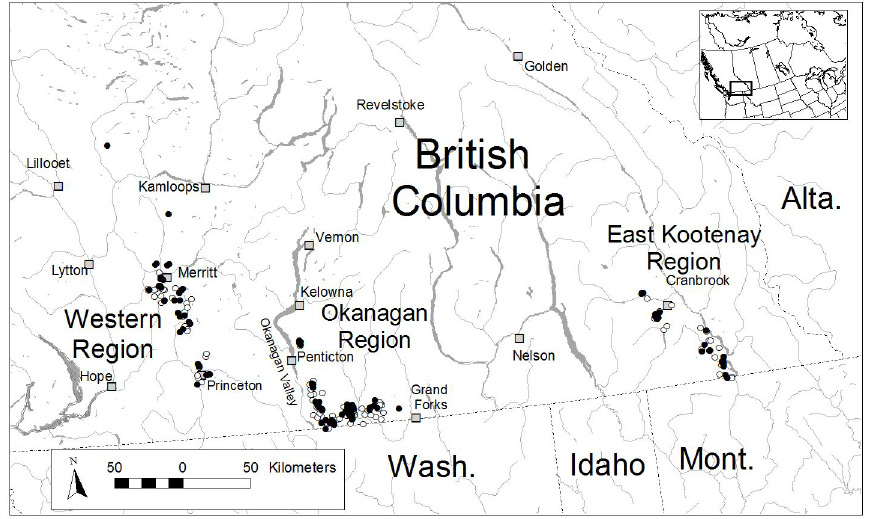
Fig 1. Map of the study area, indicating locations of Williamson ’ s sapsucker nests (black circles) and random points without detections (white circles) for three geographic regions where the species occurs in southern British Columbia,